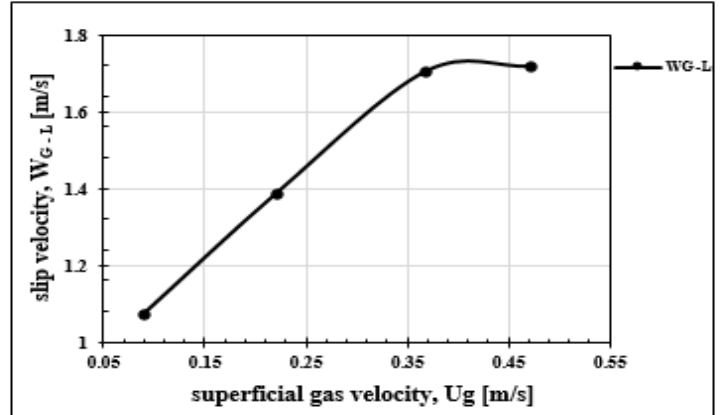
Figure 11. Relationship between slip gas velocity and superficial gas